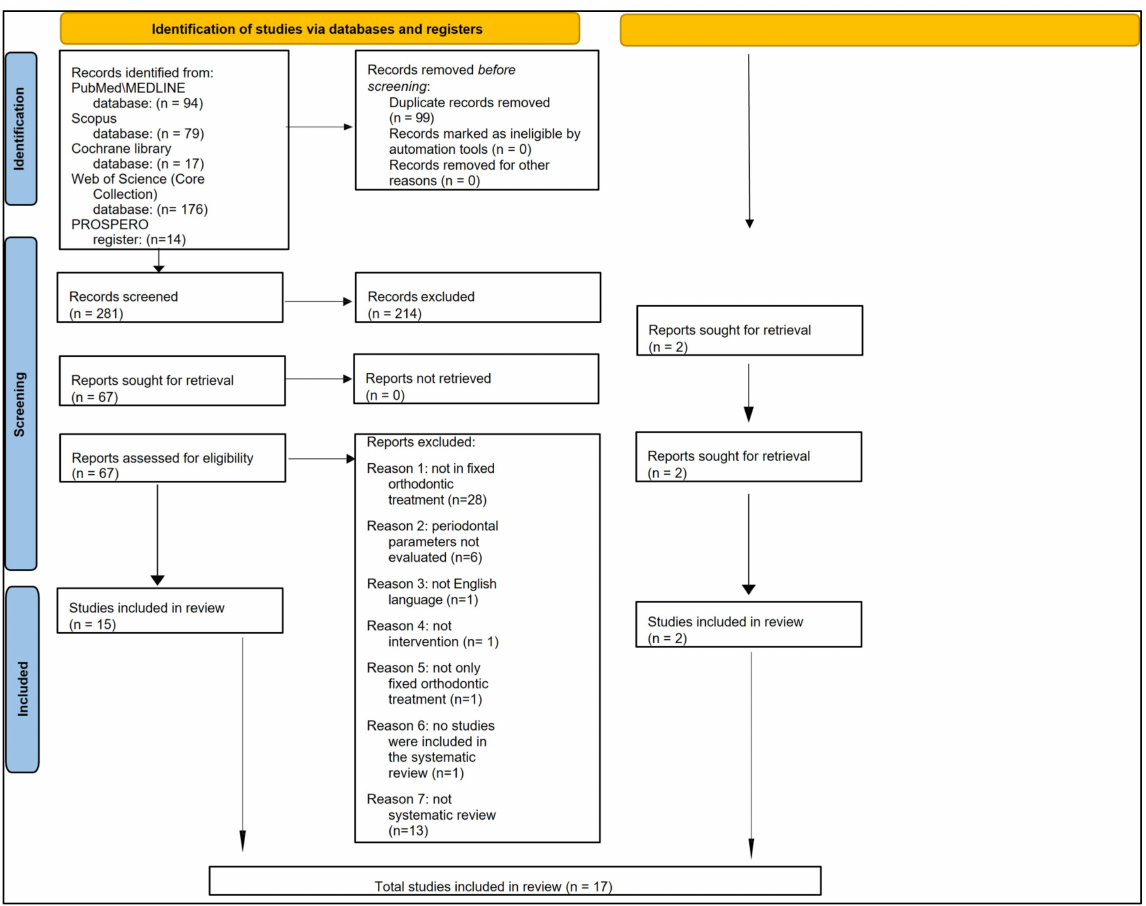
Figure 2. PRISMA 2020 flow diagram for new systematic reviews which included searches of databases, registers, and via other